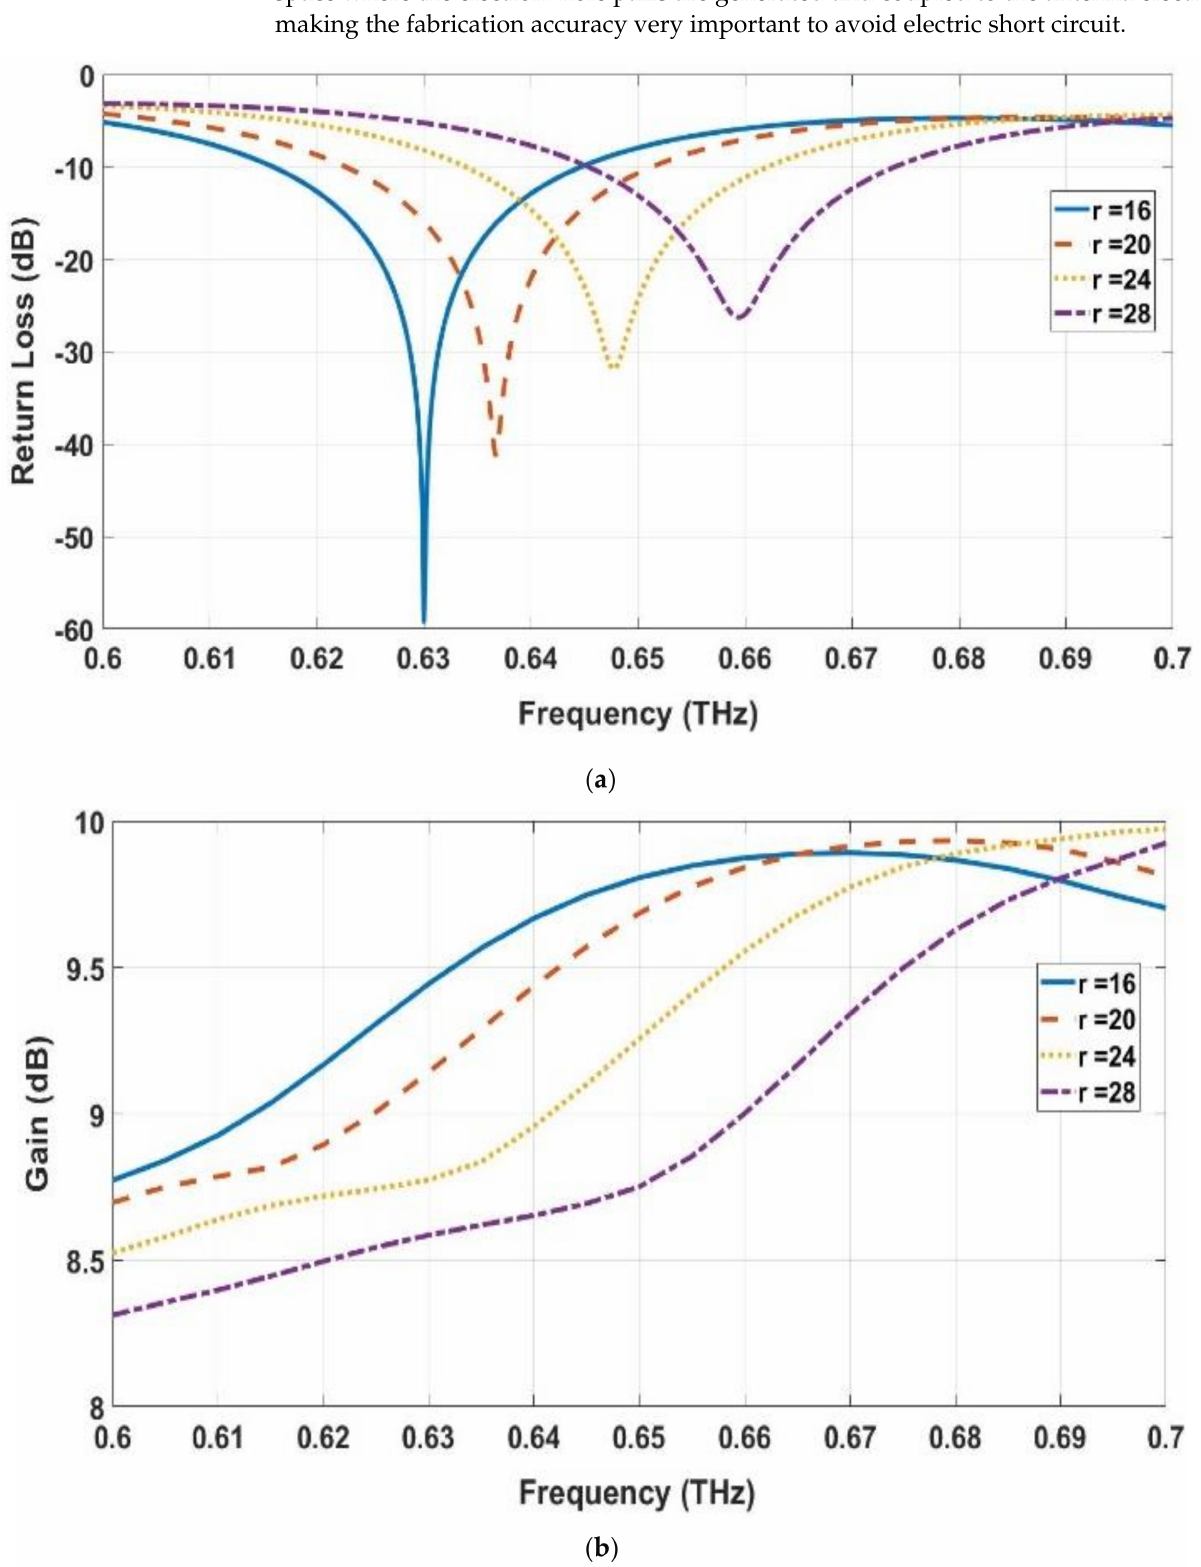
Figure 13. Parametric analysis of the proposed antenna by varying the radius, r of the PBG unit cell ( a ) return loss comparison ( b ) gain